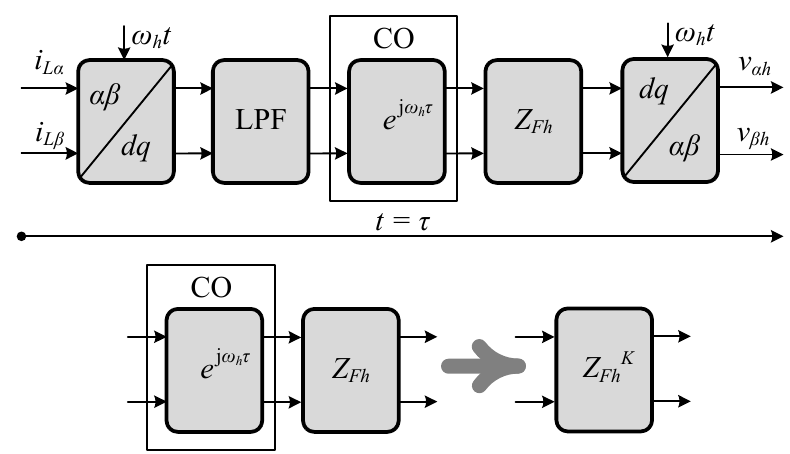
Figure 8. The modification of the CL2 control loop.